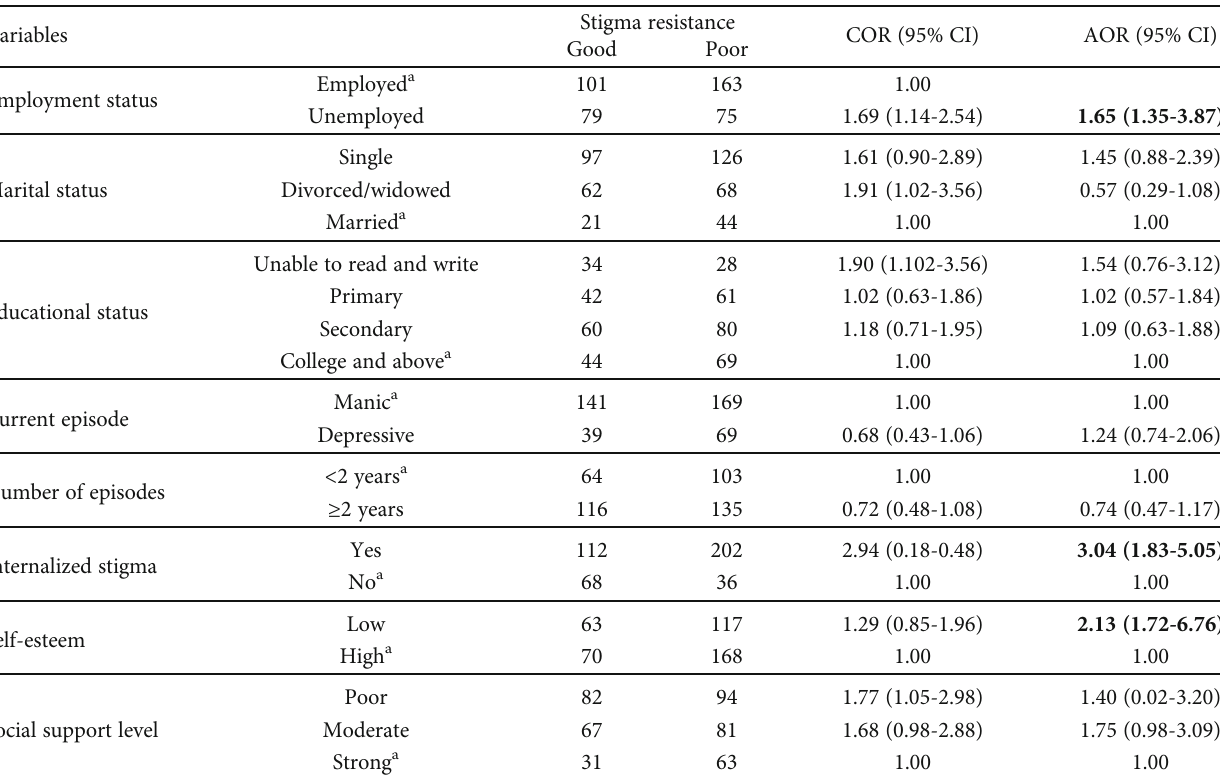
Table 3: Bivariable and multivariable analyses of stigma resistance among people with bipolar disorder attending the outpatient department at Amanuel Mental Specialized Hospital, Addis Ababa, Ethiopia, 2016 ( n = 418 ).